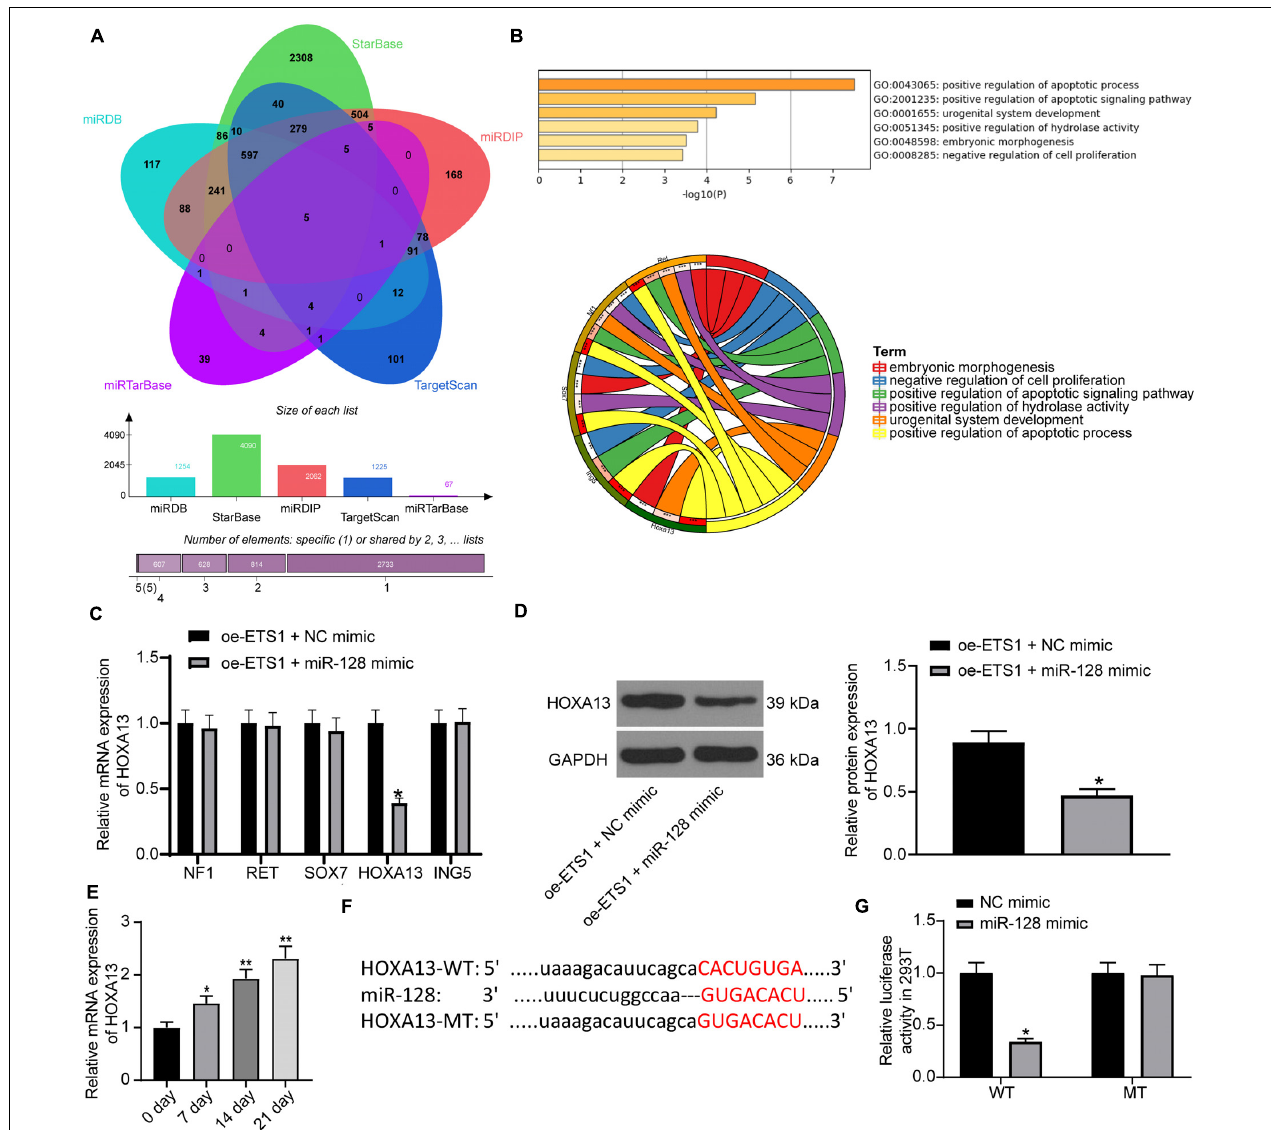
FIGURE 5 | miR-128 directly binds to HOXA13. (A) Candidate target transcripts of miR-128 predicted using five bioinformatic systems. (B) A GO pathway enrichment analysis based on the predicted genes. (C) mRNA expression of NF1, RET, SOX7, HOXA13, and ING5 in cells transfected with oe-ETS1 + NC mimic examined by RT-qPCR (two-way ANOVA, * p < 0.05). (D) Protein level of HOXA13 in cells transfected with oe-ETS1 + NC mimic determined by western blot analysis (unpaired t -test, * p < 0.05). (E) mRNA expression of HOXA13 in MC3T3-E1 cells during osteogenic differentiation examined using RT-qPCR (one-way ANOVA, * p < 0.05, ** p < 0.01). (F) Binding site between miR-128 and HOXA13 predicted on TargetScan. (G) Binding relationship between miR-128 and HOXA13 mRNA validated by a luciferase assay (two-way ANOVA, * p <